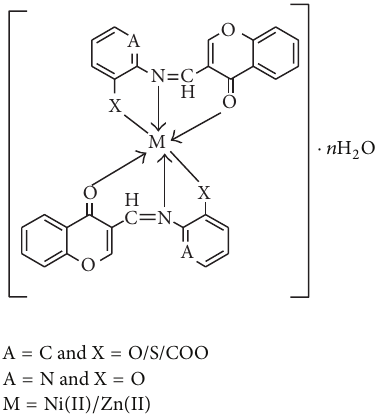
Figure 4: Proposed structure of the metal complexes.